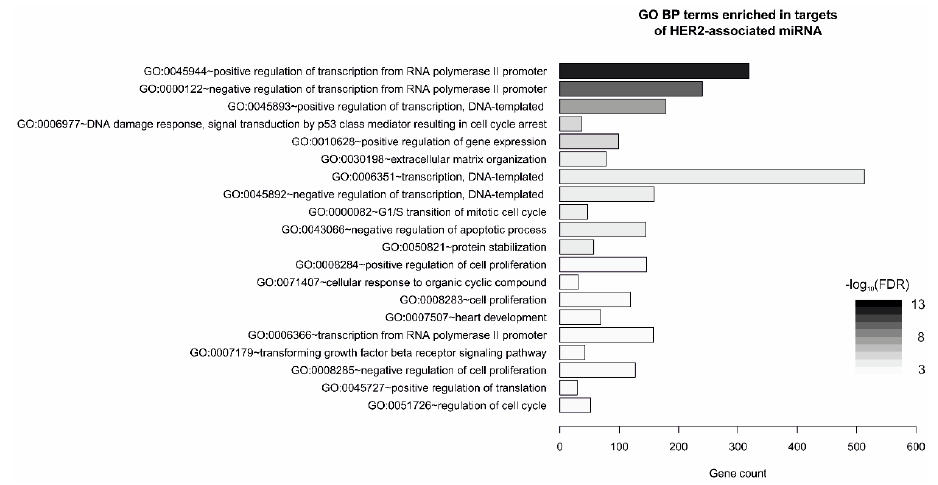
Figure 2. Gene Ontology Biological Process (GO BP) terms enriched in genes targeted by HER2-associated miRNAs in single hormone receptor-positive breast tumors; top20 terms/pathways with the lowest p -value plotted as the number of associated genes (gene count) and ordered according to -